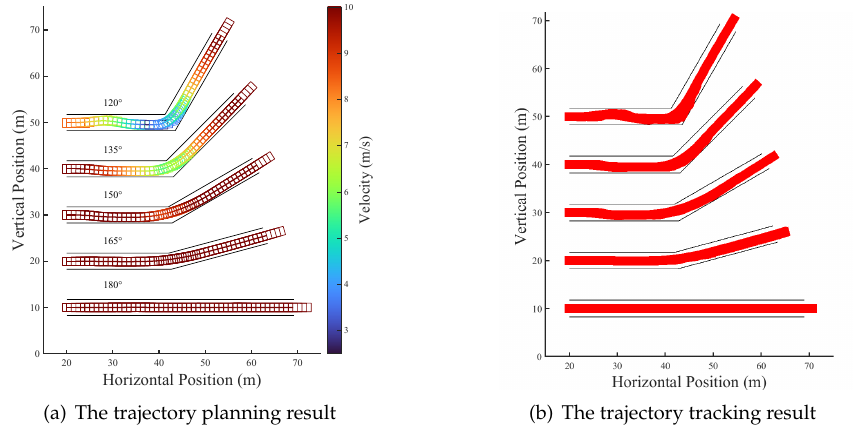
Figure 7. The simulation results in the single corner scenario. ( a ) the trajectory planning result and ( b ) the trajectory tracking result. The minimum turning angle of the proposed method is 120 ◦ and the trajectory could be tracked in different corner